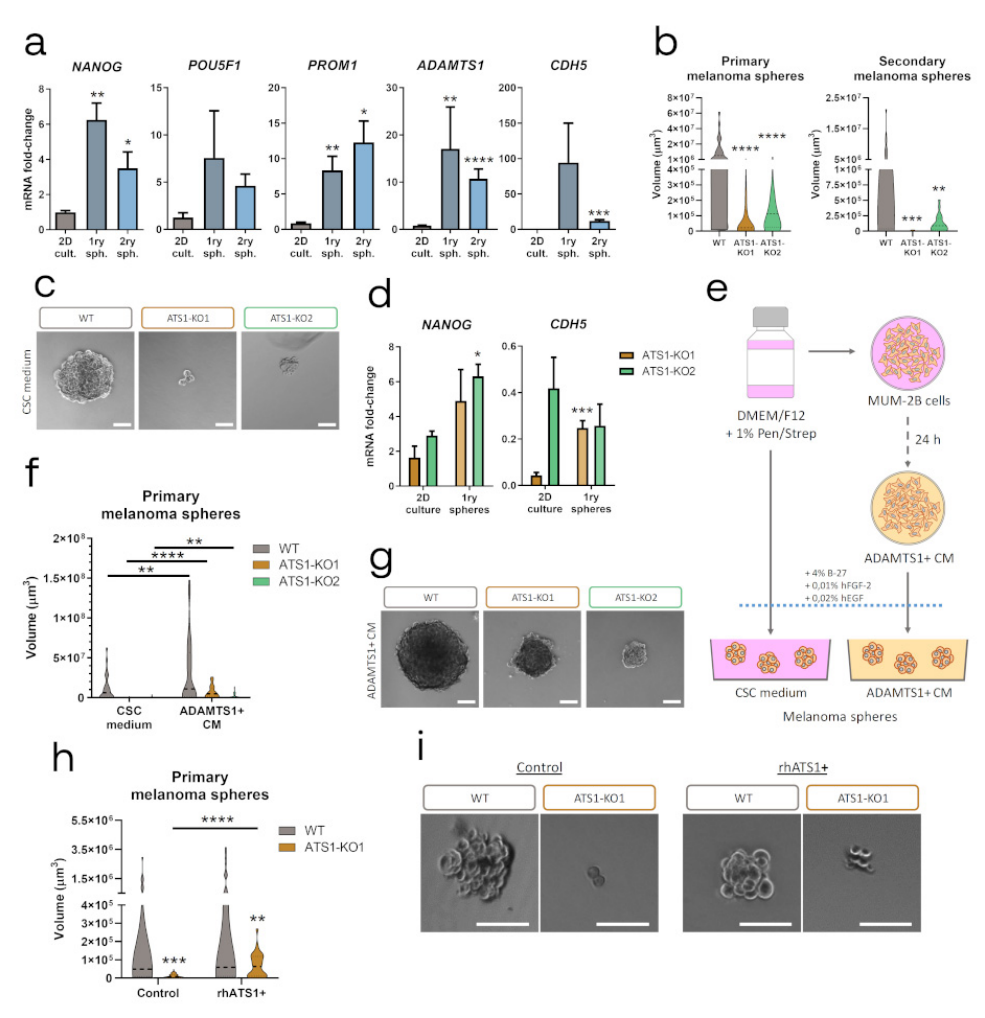
Figure 5. Inhibition of ADAMTS1 compromises melanoma sphere formation. ( a ) Graphs representing mRNA fold-change expression of NANOG, POU5F1, PROM1 , ADAMTS1 and CDH5 in MUM-2B WT 2D culture, primary and secondary melanoma spheres ( n = 4 for 2D culture, except for ADAMTS1 which is 12; n = 2–5 for primary spheres, and n = 4–6 for secondary spheres). 2D cultured cells were used as control for statistical analyses; ( b ) Violin plots representing volume of primary ( n = 49 for WT, n = 62 for ATS1-KO1, and n = 58 for ATS1-KO2) and secondary ( n = 46 for WT, n = 34 for ATS1-KO1 and n = 21 for ATS1-KO2) melanoma spheres. WT spheres volume was used as control for statistical analyses; ( c ) Representative images of WT and ATS1-KO primary melanoma spheres grown in CSC medium; ( d ) Graphs representing mRNA fold-change expression of NANOG and CDH5 in 2D culture ( n = 4–6 for ATS1-KO1 and n = 2–4 for ATS1-KO2) and primary melanoma spheres ( n = 2 for ATS1-KO1 and n = 4–7 for ATS1-KO2). 2D cultured conditions were used as control for statistical analyses; ( e ) Schematic protocol for melanoma spheres formation, using CSC medium and ADAMTS1+ CM; ( f ) Violin plots representing volume of WT and ATS1-KO primary melanoma spheres grown in CSC medium ( n = 49 for WT, n = 62 for ATS1-KO1, and n = 58 for ATS1-KO2) or in ADAMTS1+ CM ( n = 44 for WT, n = 48 for ATS1-KO1, and n = 49 for ATS1-KO2); ( g ) Representative images of WT and ATS1-KO primary melanoma spheres in ADAMTS1+ CM; ( h ) Violin plots representing WT and ATS1-KO1 primary melanoma spheres, grown in control CSC ( n = 27 for WT, and n = 44 for ATS1-KO1) or rhATS1+ CSC medium ( n = 35 for WT, and n = 28 for ATS1-KO1); ( i ) Representative images of WT and ATS1-KO1 primary melanoma spheres grown in control and rhATS1+ CSC medium. (****, p < 0.0001; ***, p < 0.001; **, p < 0.01; *, p < 0.05. Violin plots indicate the median of every experimental group. White scale bar = 100 µm).